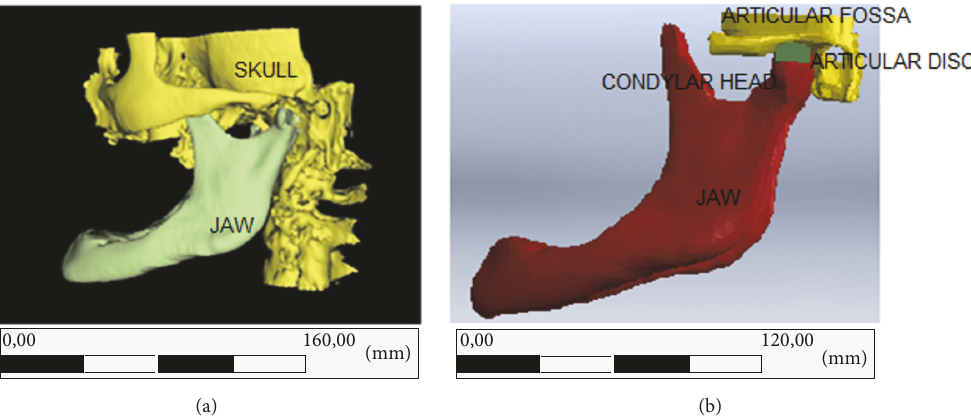
Figure 2: Image of skull-mandibular region of the patient (a) and (b) model proposed by the separation of the TMJ region in three components, jaw (red), articular fossa (yellow), and articular disc